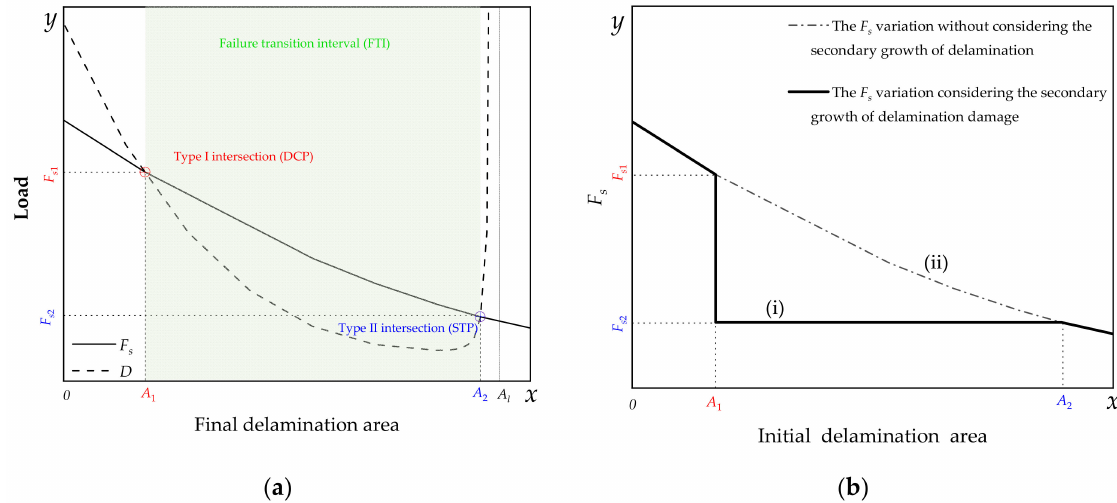
Figure 15. Schematic diagram of dynamic damage relationship during compression: ( a ) F s —final delamination area curves, ( b ) F s —initial delamination area